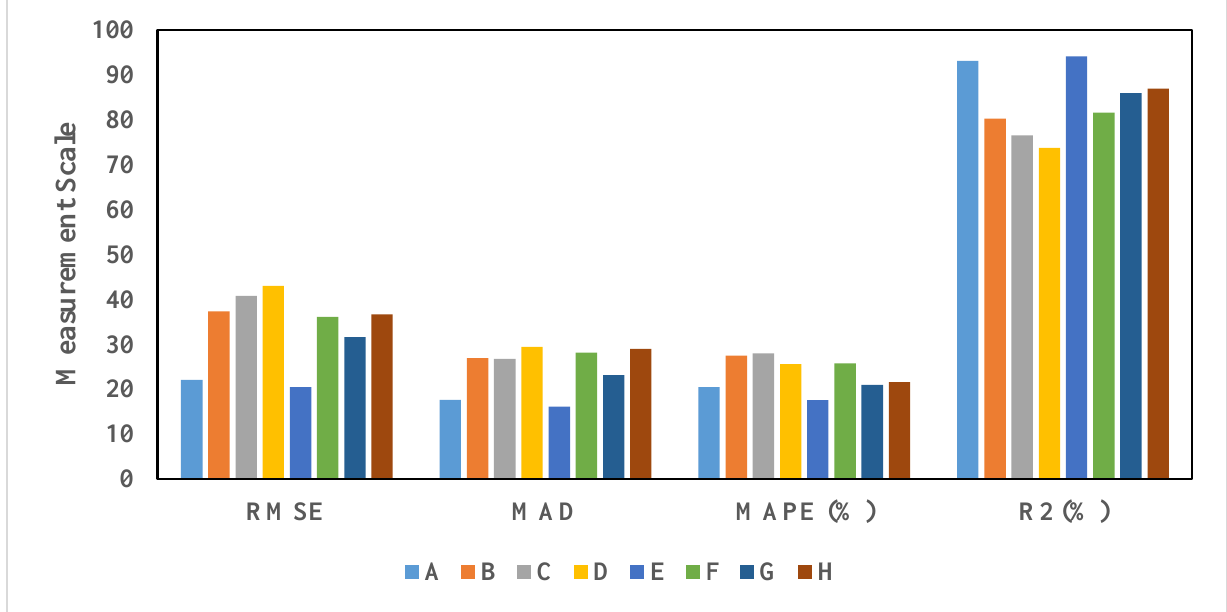
Figure 7. Sensitivity analysis of input variables on apple yield in ANN model. A: The best ANN model without CD; B: The best ANN model without FI; C: The best ANN model without FDI; D: The best ANN model without FD; E: The best ANN model without plant girth; F: The best ANN model without canopy spread; G: The best ANN model without plant height; H: The best ANN model (with plant height, canopy spread, plant girth, FD, FDI, FI, and CD as the input). The ability of ANN to predict apple yield was significantly decreased when it was run without FI, FDI, and FD. The models without FD have the lowest R 2 and highest RMSE (79.47), MAD (79.44), and MAPE (23.07). Therefore, FD can be considered as an